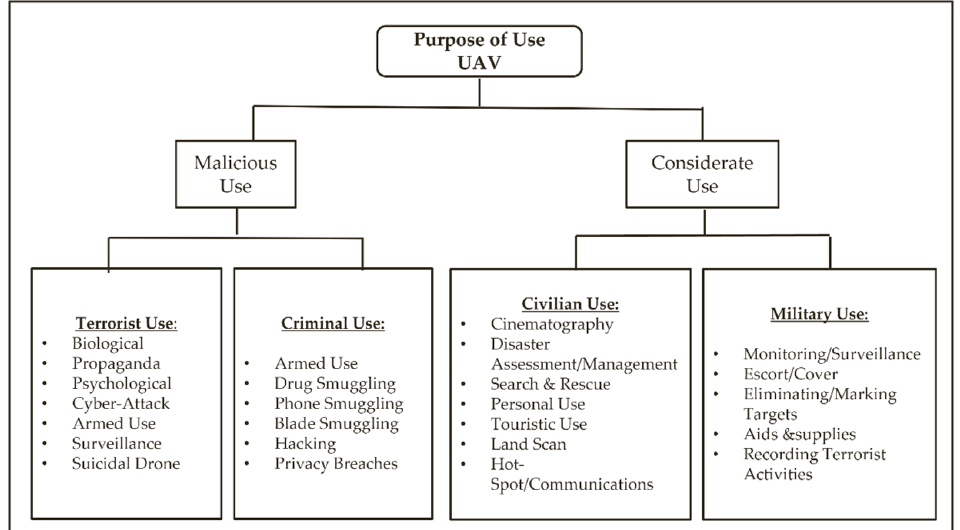
Figure 2. Purposes of UAV usage.